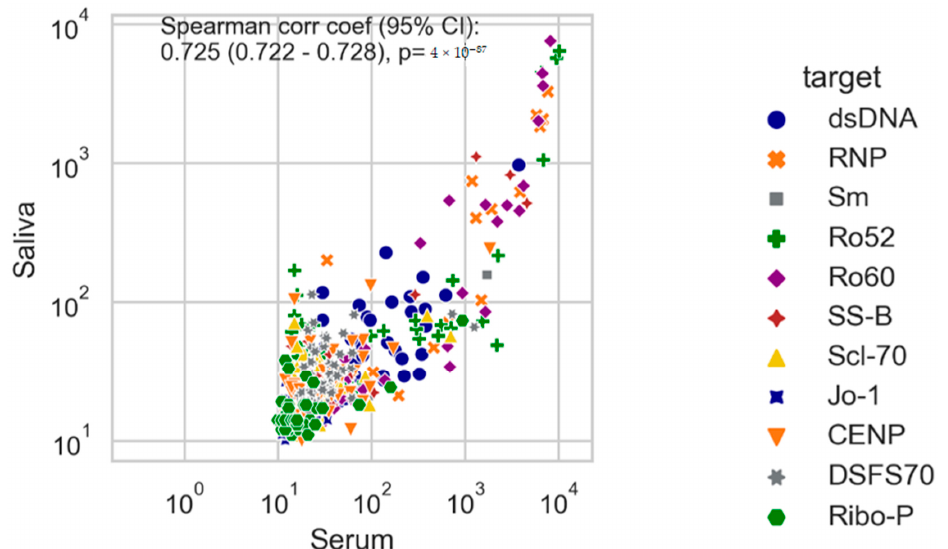
Figure 2. Autoantibodies levels measured in saliva in patients negative or positive based on the serum test results. The color code indicates the identity of the respective autoantibody (dsDNA, RNP, Sm, Ro52, Ro60, SS-B, CENP, Scl-70, Ribo-P, Jo-1). Correlation between serum and saliva. rho = 0.73